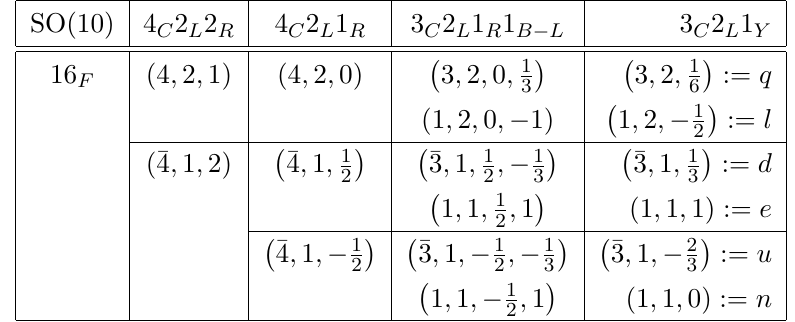
Table 1 . Decomposition of the fermion multiplets according to the various subgroups in our breaking chains. All SM fermions have masses set by the Higgs mechanism, the heavy right handed neutrinos acquire their mass at the BL breaking scale from the coupling to the 126 H